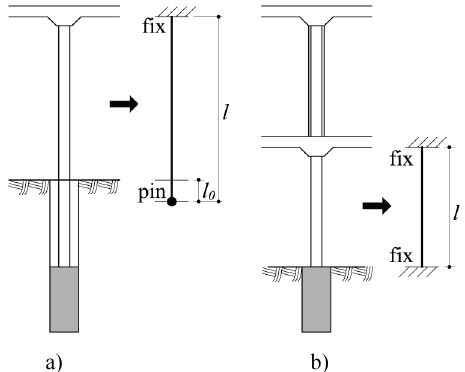
Fig. 4. Idealization of both ends of the exposed steel column in the excavation phases: (a) during excavation and (b) in the final excavation phase